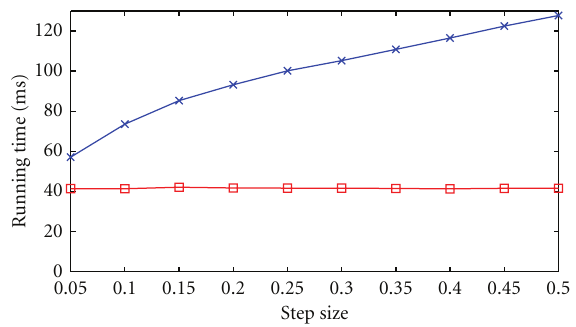
Figure 6: Running time for varying step size for in-kernel interpolation (blue) and texture-filtering interpolation (red).